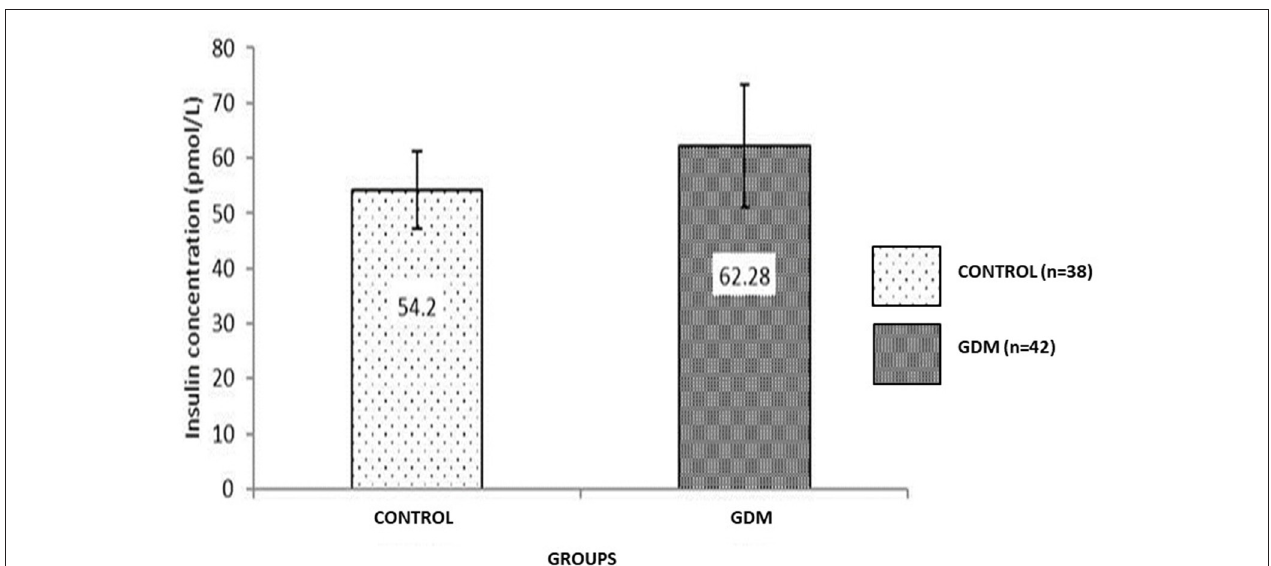
FIGURE 2 | Comparison of insulin UCB (pmol/L) concentration between GDM and Control groups. The insulin level in the GDM group is comparable with the Control group. Data shown is mean ± SEM.